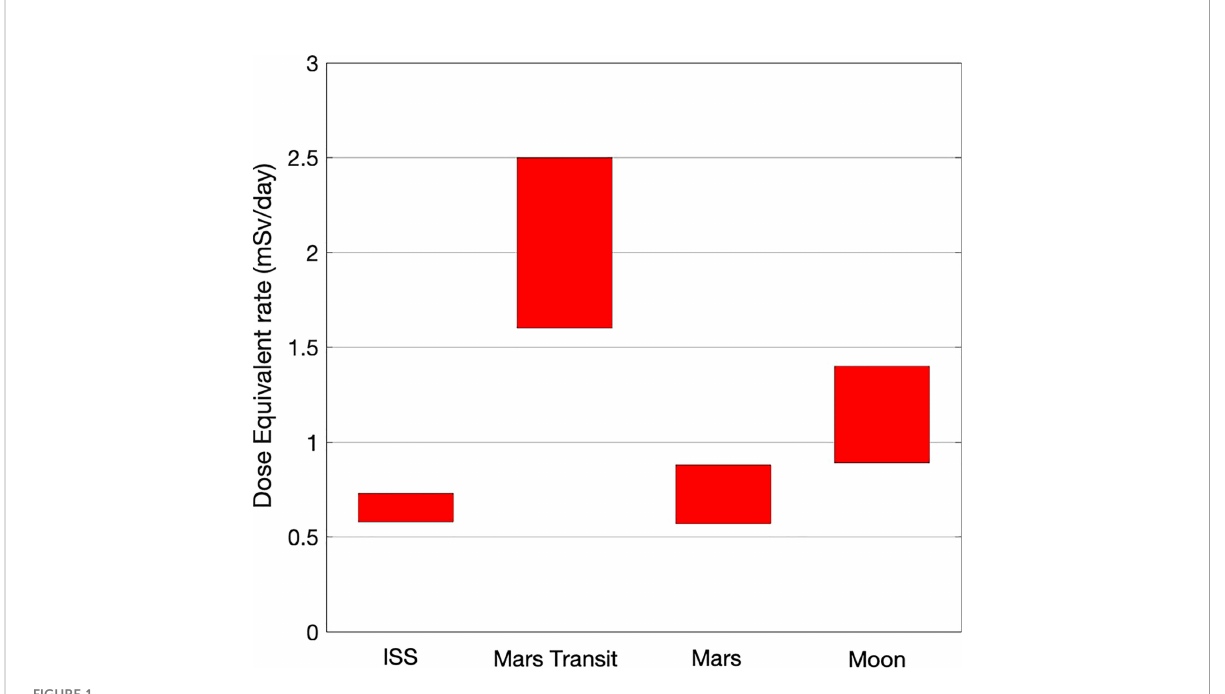
FIGURE 1 Ranges (maximum-minimum of solar activity) of dose equivalent in relevant